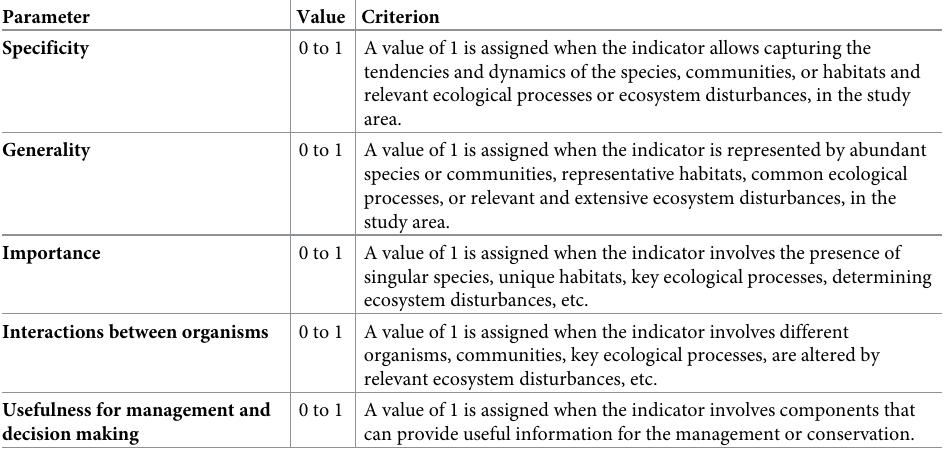
Table 3. Summary of the assessment parameters used to select the priority indicators by a quantitative priority index using five parameters with its specific